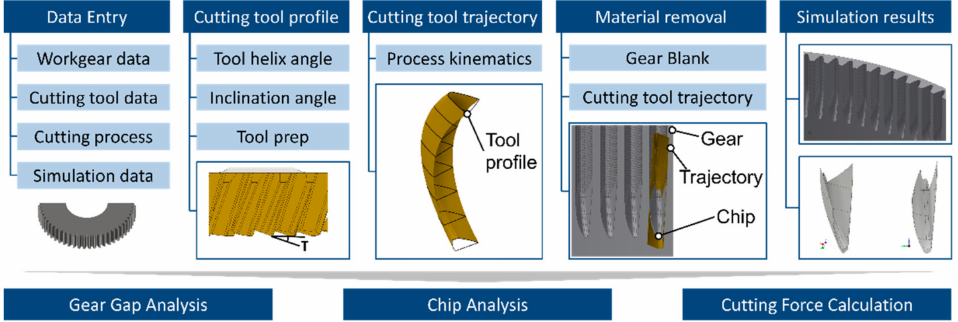
Figure 2. Skive3D simulation